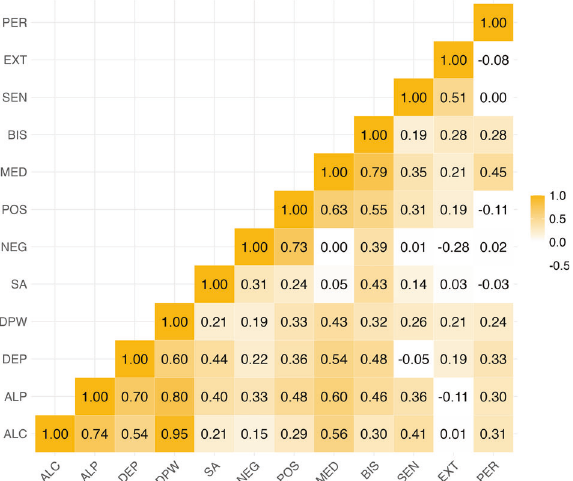
Fig. 1 Pairwise genetic correlations between alcohol consump- tion and problems, suicide attempt, and impulsive personality traits. Standard errors can be found in Table